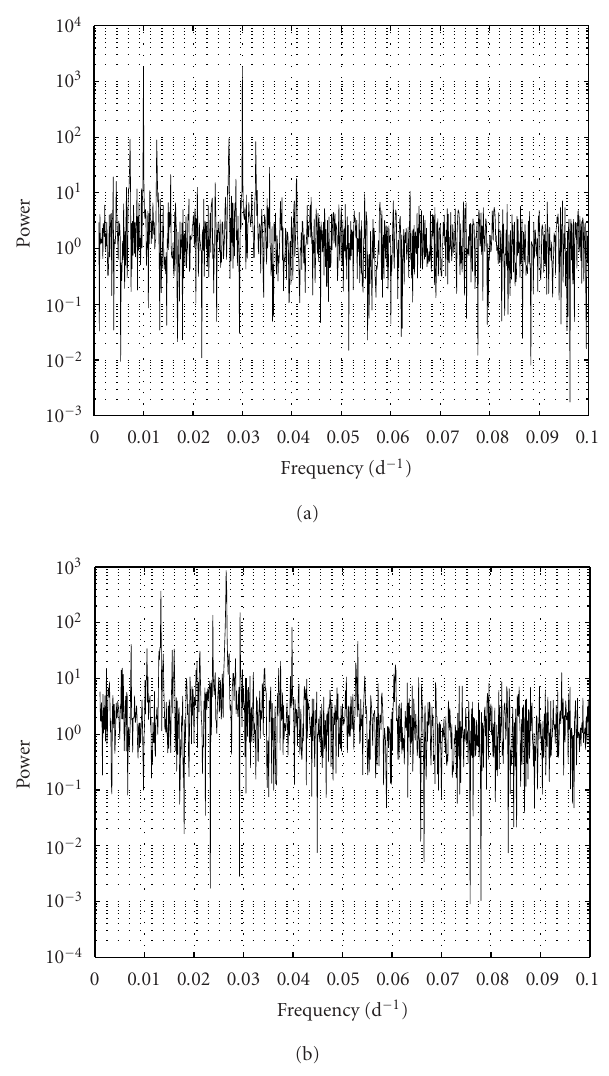
Figure 4: Periodograms from the RV Tauri light curve (b) and from the corresponding simulated signal (a), presented on a logarithmic